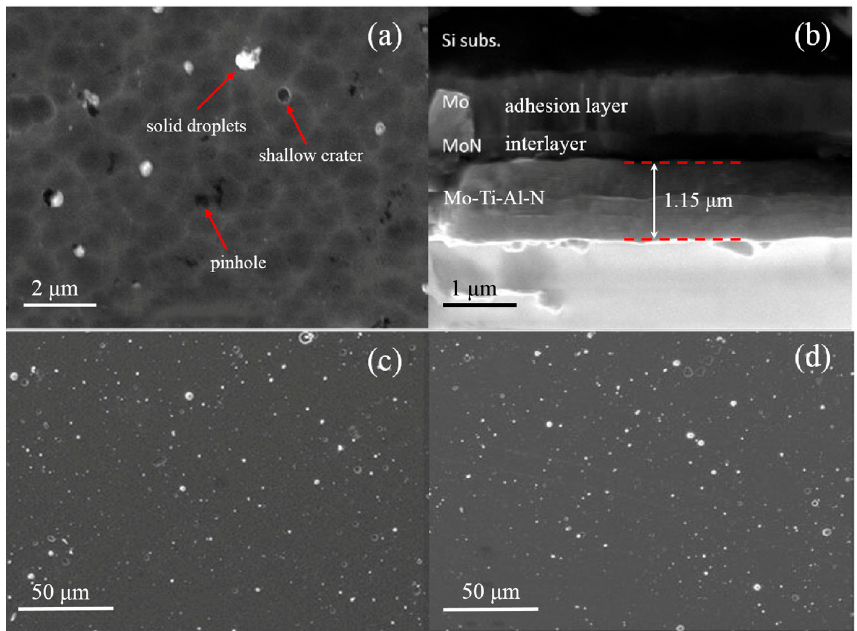
Figure 3. SEM images of Mo-Ti-Al-N composite coatings fabricated: surface morphological ( a ) and cross-sectional ( b ) images at 2 rpm; surface morphological images ( c ) at 1 rpm and ( d ) at 3 rpm.